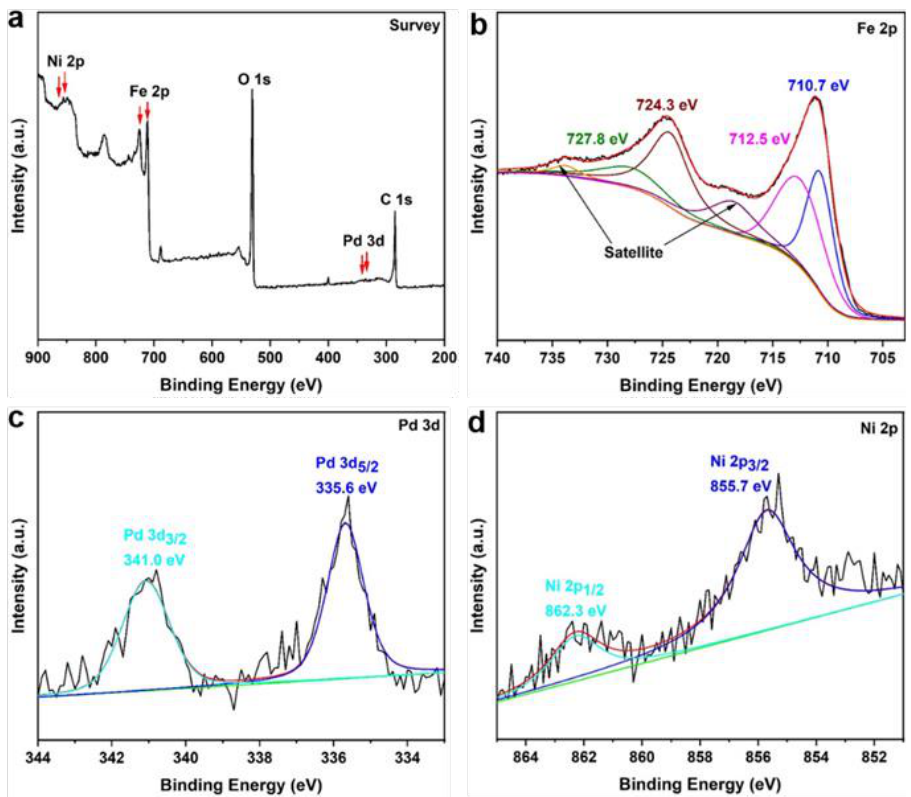
Figure 5. ( a ) XPS survey spectra of Ni-Pd/Fe 3 O 4 . High-resolution spectra of Fe 2p ( b ), Pd 3d ( c ), and Ni 2p ( d ).